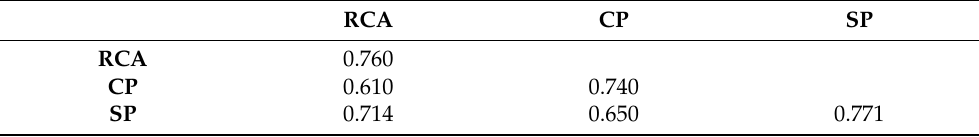
Table 4. Fornell-Larcker Criterion.